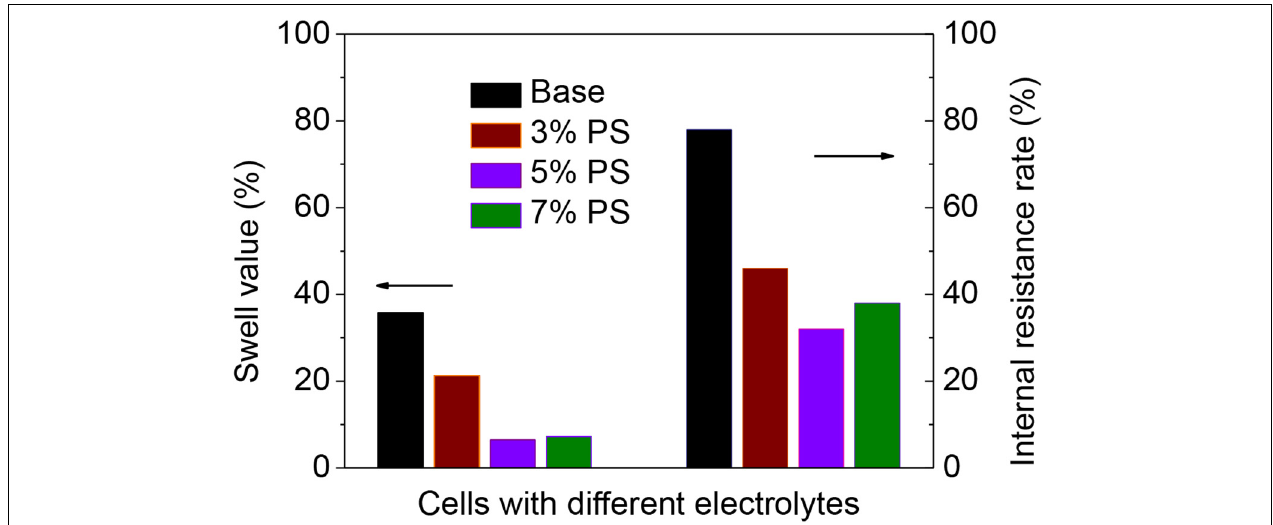
FIGURE 3 | Swell value and internal resistance rate of LiMn 2 O 4 /graphite cells using the electrolyte without (Base) and with variable concentrations of PS after 180 cycles at 60 ◦ C.